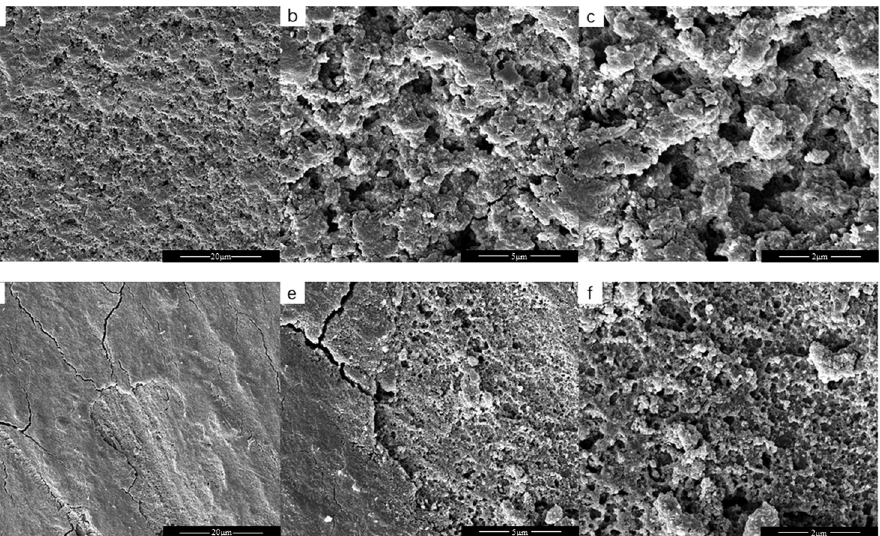
Figure 9: SEM images on coating - exfoliated steel surfaces after 16 days of immersion in 3.5 wt% NaCl solution, ( a – c ) EL@AR - P 0 , ( d – f ) EL@AR - P ( a and d ) magni fi cation level of 2,000 × , ( b and e ) magni fi cation level of 10,000 × , ( c and f ) magni fi cation level of 20,000 × 2 ,